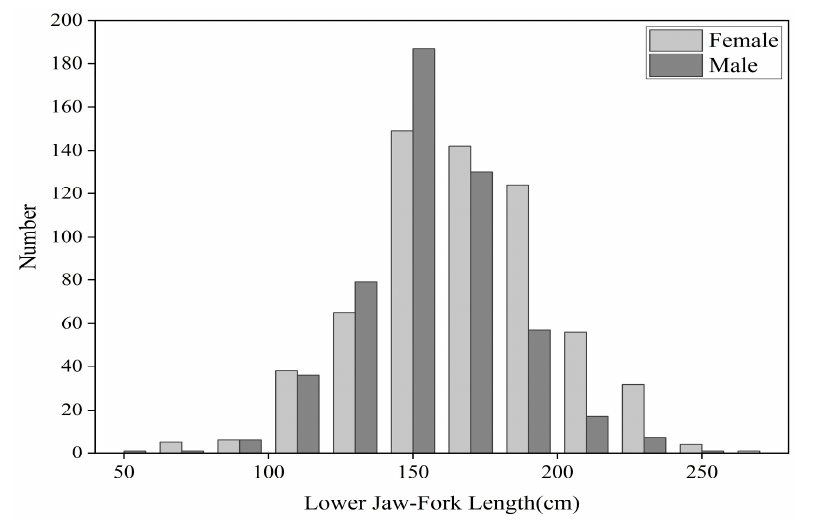
Figure 2. The distribution of lower jaw-fork length of female and male swordfish in the Indian Ocean from 2012 to 2018 in this study.